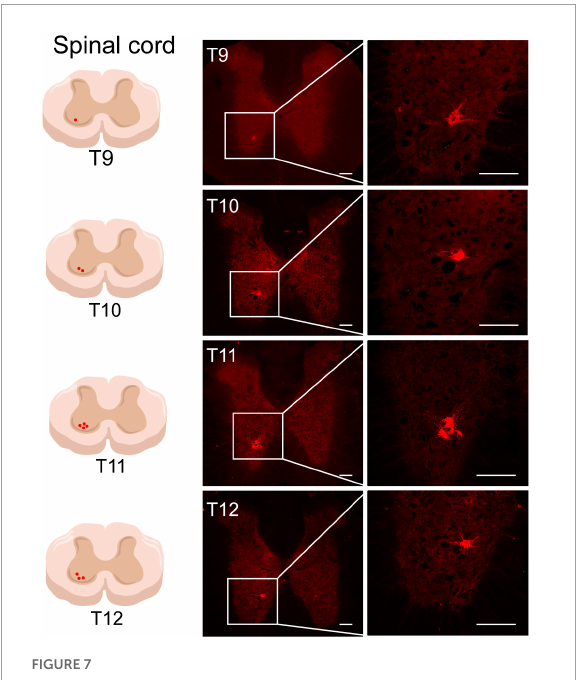
FIGURE7 The neural tracing of ST25 in the spinal cord. Representative and magnified photomicrograph showing the distribution of AF594-CTB-labeled motor neurons in the T9–T12 spinal cord. Scale bars = 100 µ m.